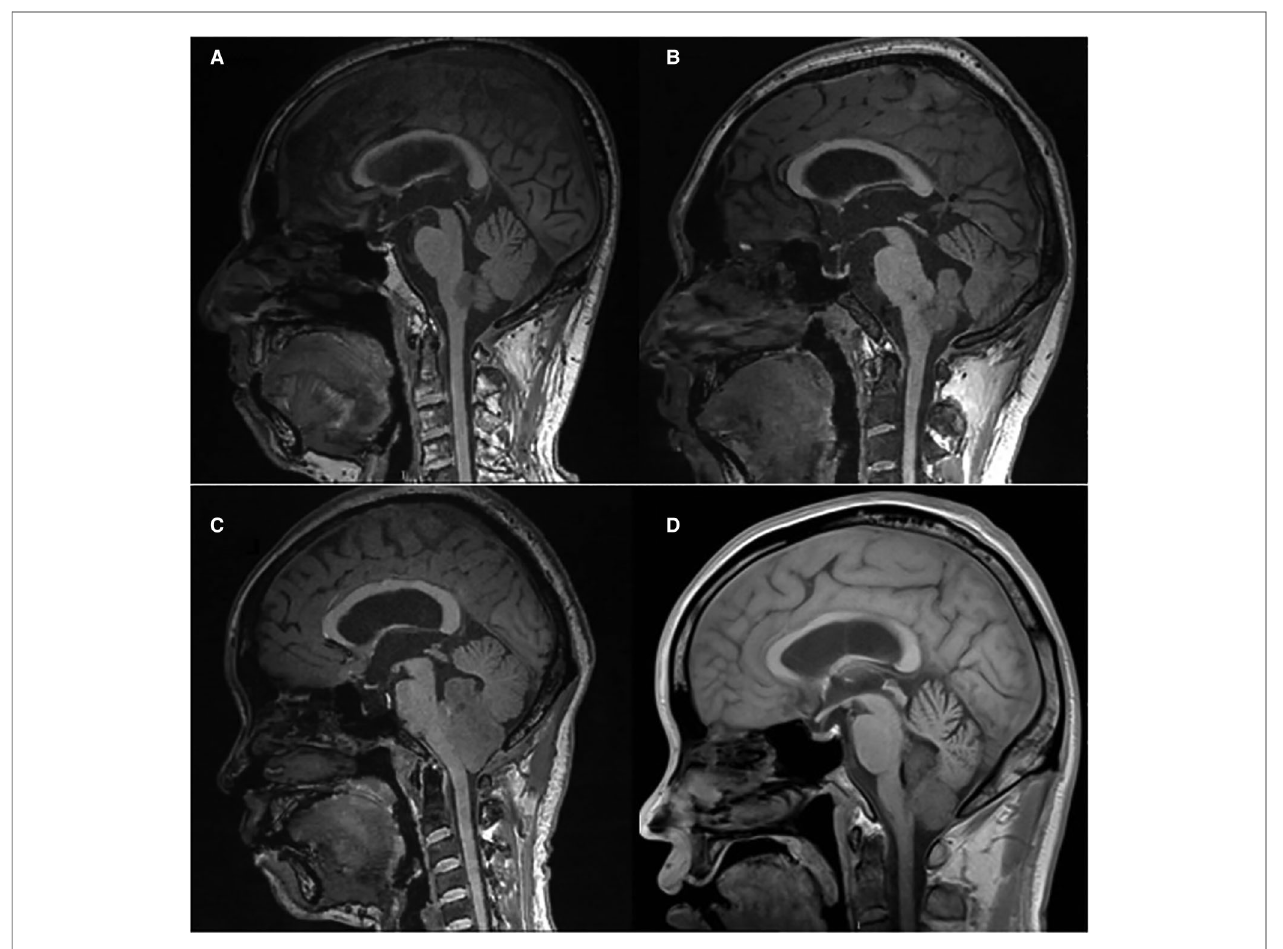
FIGURE 2 | ( A ) and ( B ): sagittal (T1) views of type L2 tumor, ( C ) and ( D ): sagittal (T1) views of type L3